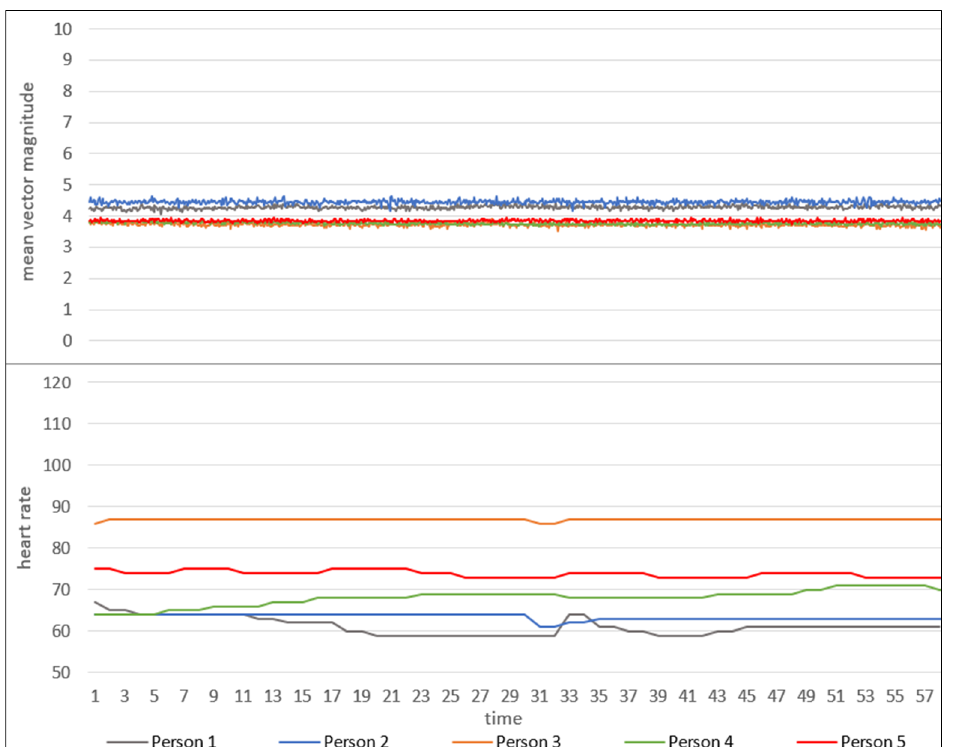
Figure 5. Heart rate and acceleration for the complete calm pattern estimated for five people. Future Internet 2020 , 12 , 111